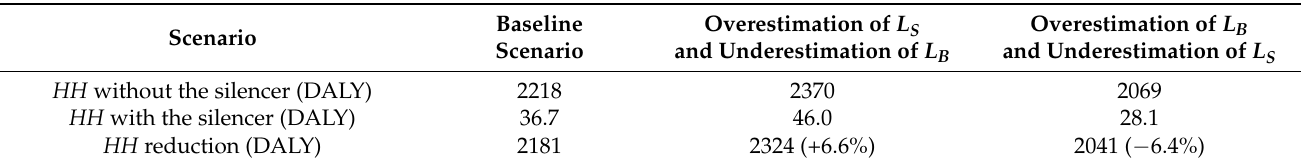
Table 3. The deviation of HH indicators due to potential errors in the assessment of area shares attributed to various noise levels L S and L B .